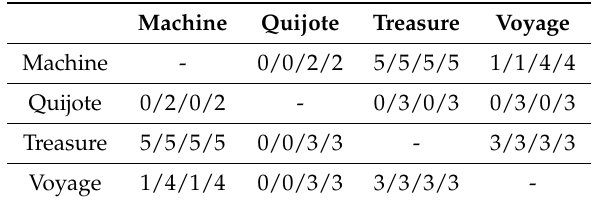
Table 20. Test results for dissimilar plain text files with SiSe (hash vs. hash/file vs. hash/hash vs. file/file vs.